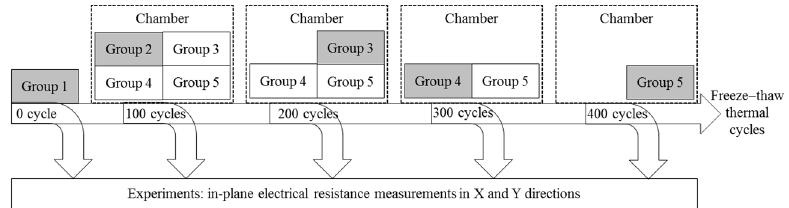
Figure 2. Group division of GDLs going through different degrees of freeze–thaw thermal treatment.